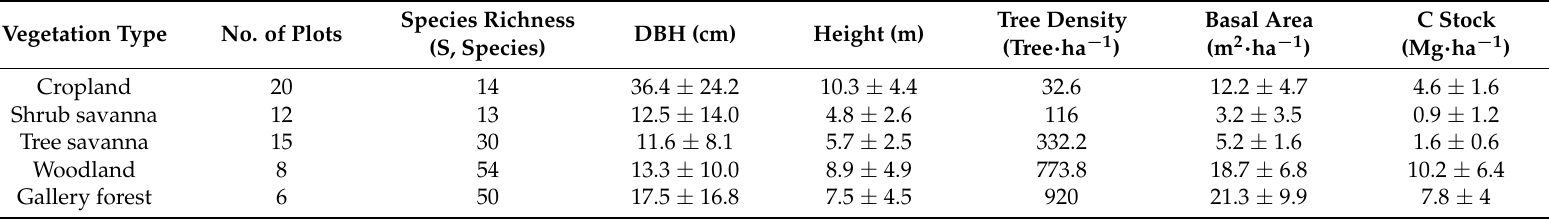
Table 4. Plant community type